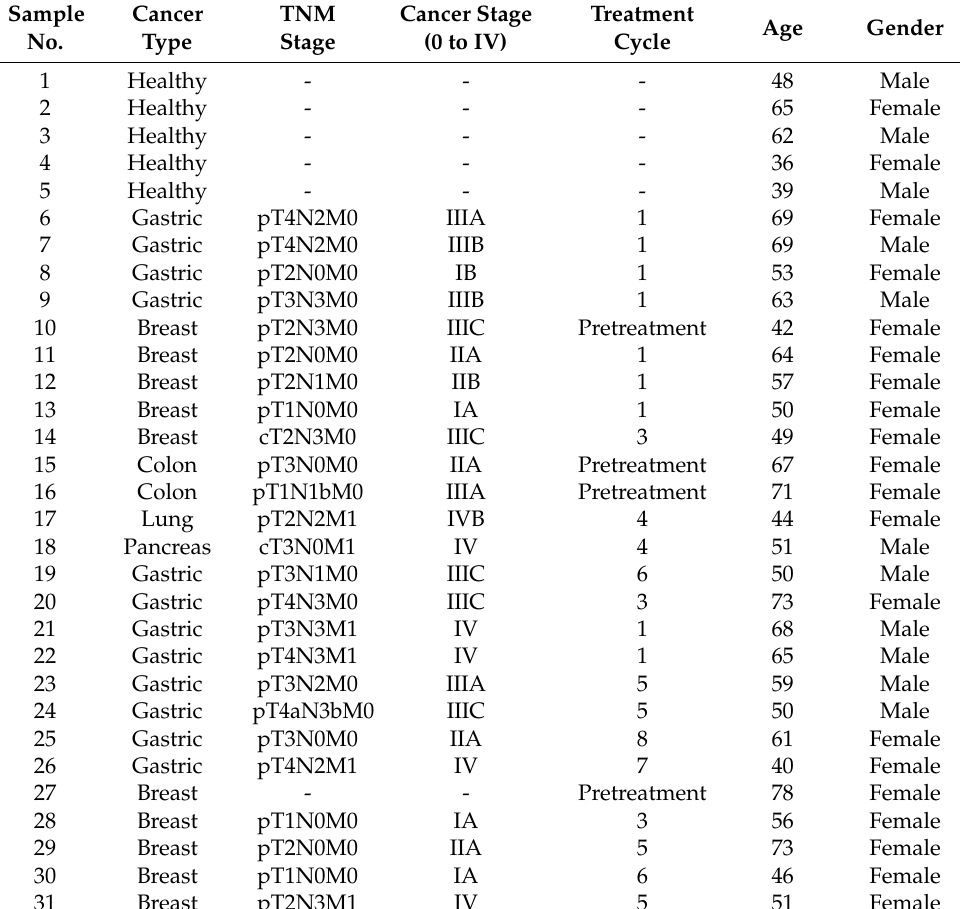
Table 1. Clinical demographics of cancer patients. p = pathological, c = clinical, T = size or direct extent of the primary tumor, N = degree of spread to regional lymph nodes, M = presence of distant